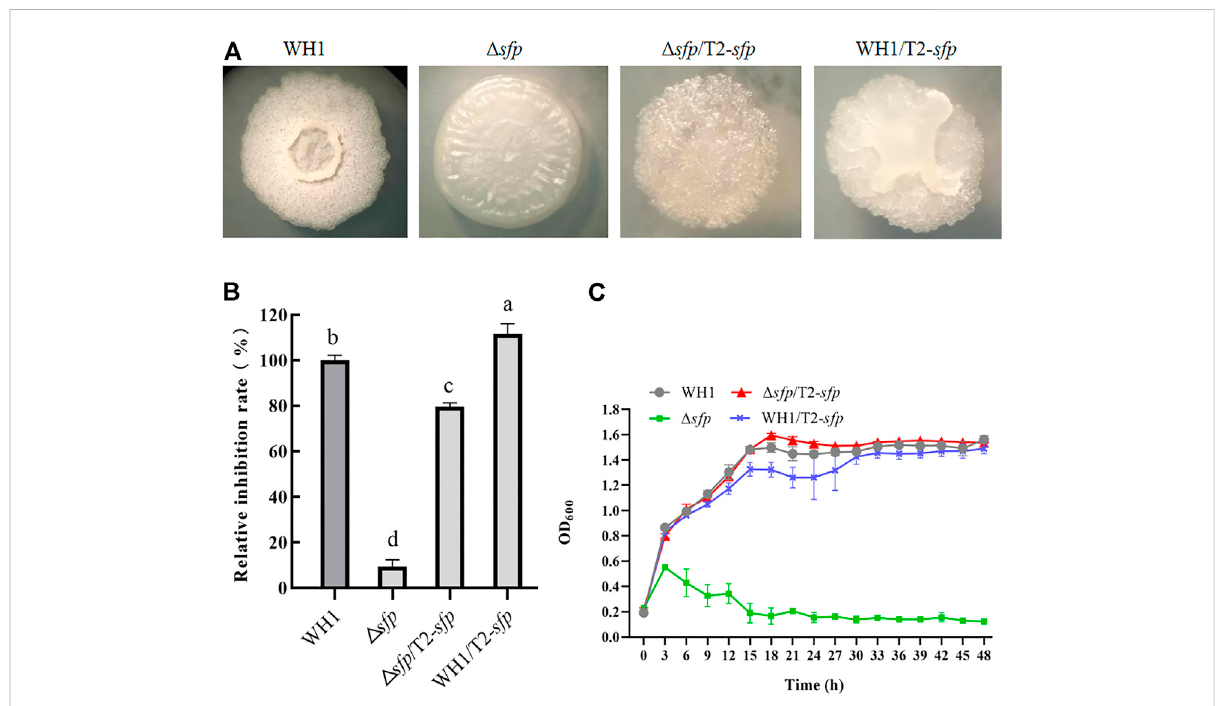
FIGURE 9 Relative inhibition rates and characteristics of engineered strains related with sfp . (A) : Colony morphology; (B) : Relative inhibition rates; (C) : Growth